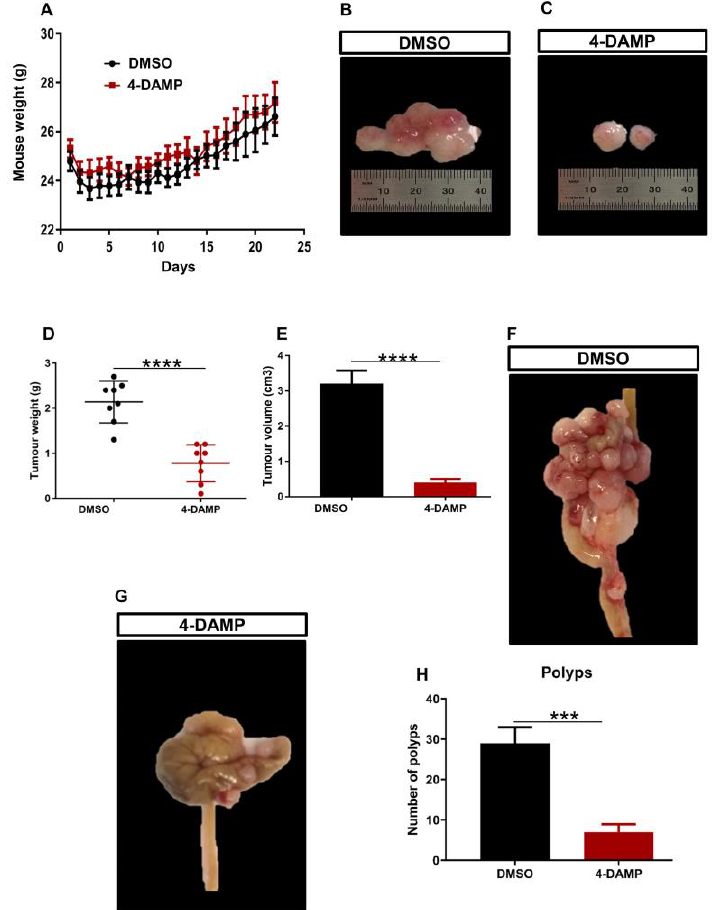
Figure 4. Effect of 4-DAMP on tumor growth in vivo. Body weight of mice treated with a vehicle (0.1% DMSO) and 4-DAMP (10 mg/kg daily) ( A ). Images of tumor size from DMSO-treated group ( B ) and 4-DAMP-treated group ( C ). Bar graphs displaying the mean weight ( D ) and volume ( E ) of tumors collected from DMSO and 4-DAMP-treated groups. The caecum samples were removed from tumor-bearing mice treated with DMSO ( F ) and 4-DAMP ( G ). Bar graph displaying the mean number of tumor polyps from DMSO and 4-DAMP-treated groups ( H ). Data presented as mean ± SEM, n = 8 mice per group. Student’s t -test, *** p < 0.001, **** p <